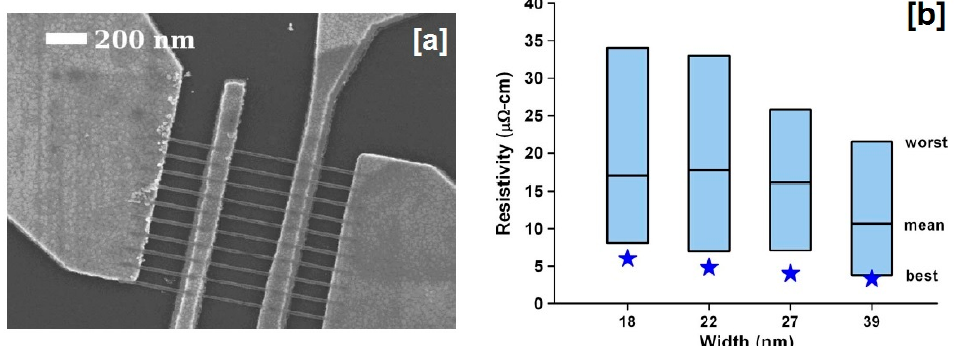
Figure 13. ( a ) SEM image of a set of ten GNRs between each electrode pair; ( b ) Performance of individual GNRs of various line widths. The equivalent Cu resistivity is shown by a star [9]. Reproduced with permission from [9]. IEEE, 2009.